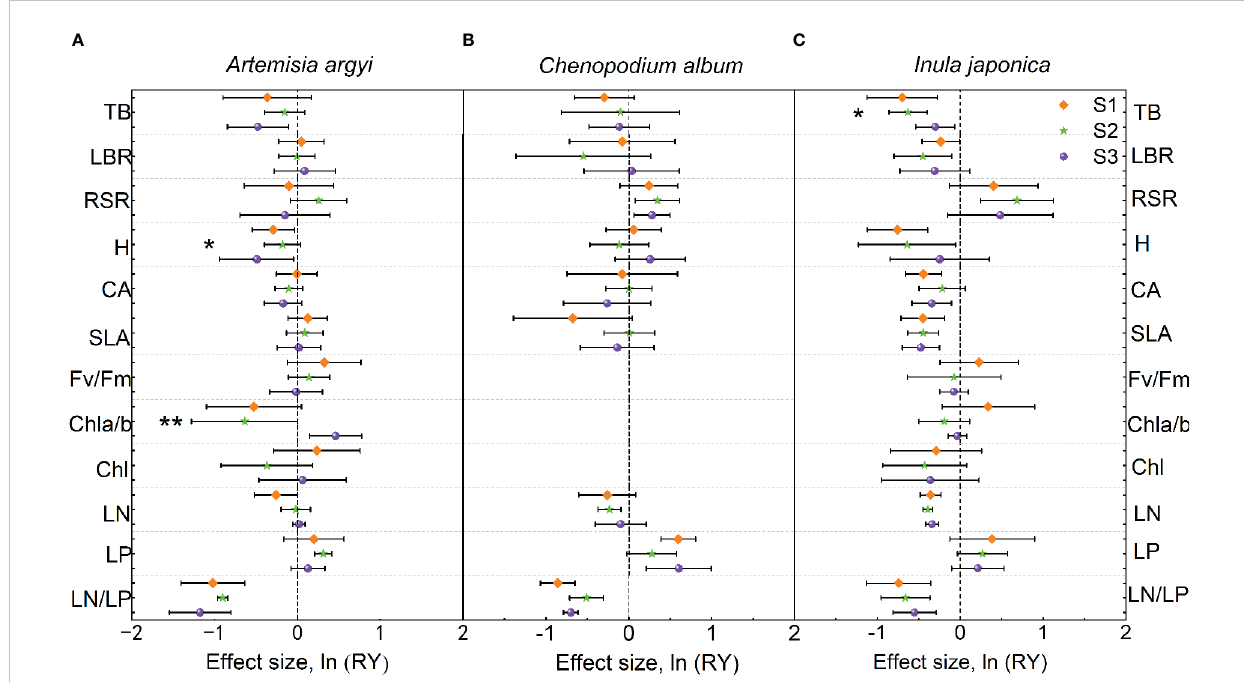
FIGURE 4 Effect sizes of mixture plantation (biological interaction) with invasive species ( Oenothera biennis ) on three native species ( Artemisia argyi , Chenopodium album , and Inula japonica ) traits in three salinity treatments. The orange diamond illustrates the S1 treatment (control), the green pentagram illustrates the S2 treatment (low salt treatment), and the purple sphere illustrates the S3 treatment (high salt treatment). Error bars are 95% con fi dence intervals. Signi fi cant effect sizes are indicated by con fi dence intervals that do not overlap zero. The asterisk in the fi gures indicates signi fi cant effects of salt stress on different functional traits of native species under interspeci fi c interaction. The capital letters represent the traits of three native species - A. argyi (A) , C. album (B) , and I. japonica (C) when mixed with O . biennis and when monoculture. Abbreviations have identical meanings as described in Table 1.